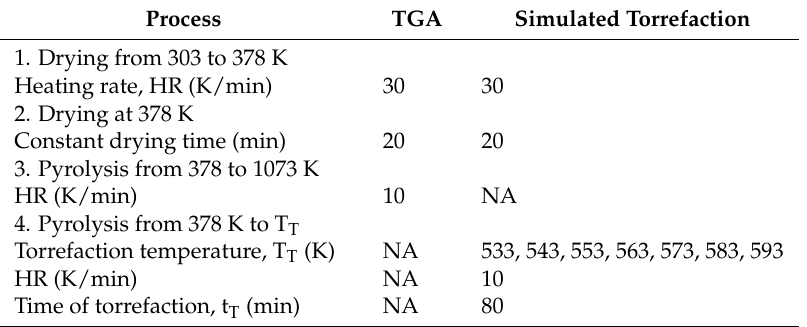
Table 4. Temperature control of thermal gravimetric analysis (TGA).